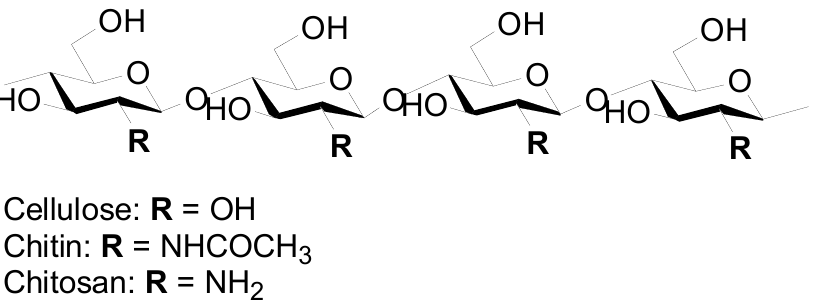
Figure 1. Chemical structures of cellulose, chitin, and